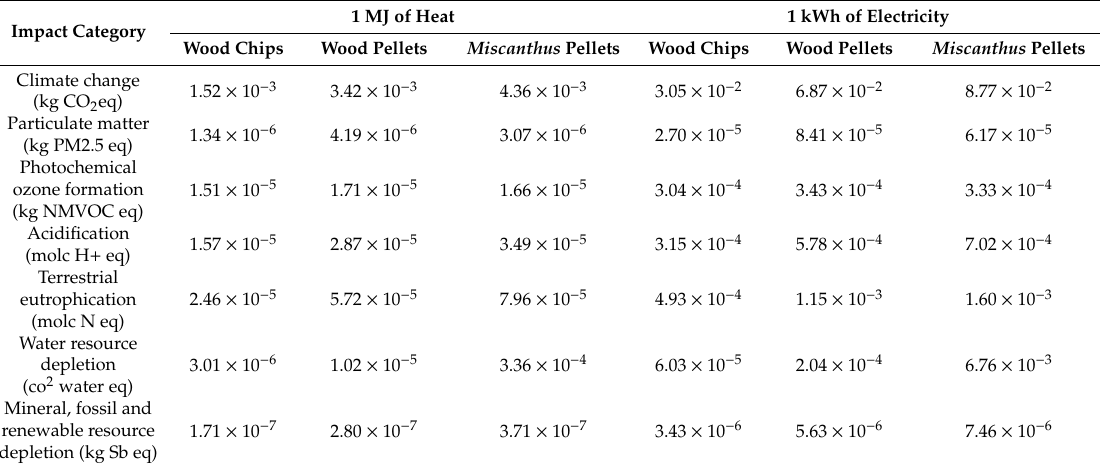
Table A1. Cradle-to-grave environmental impacts per functional unit and biomass fuel. WC = wood chips, WP = wood pellets, MP = Miscanthus